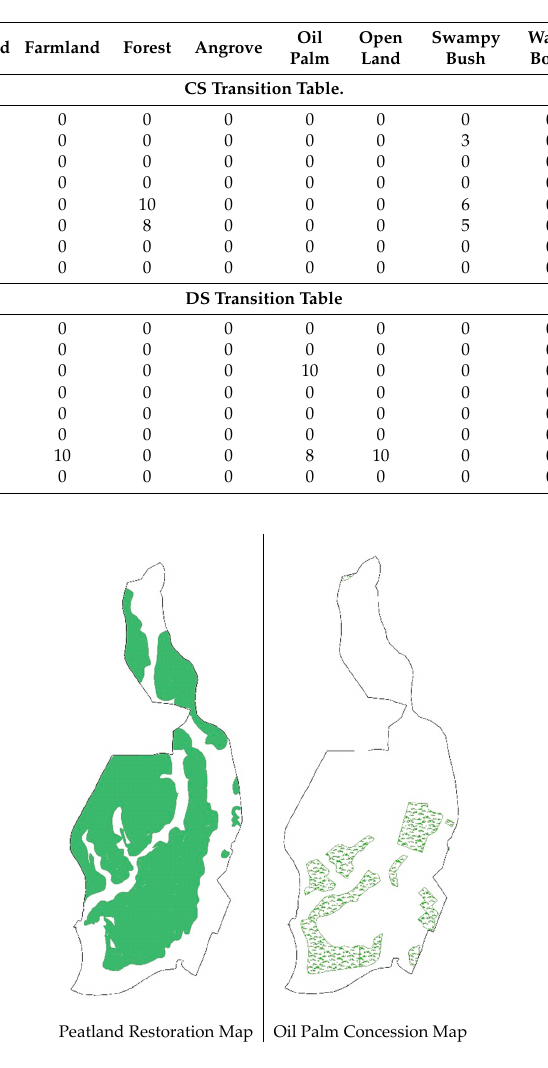
Table A2. Input data for the InVEST Scenario Generator.